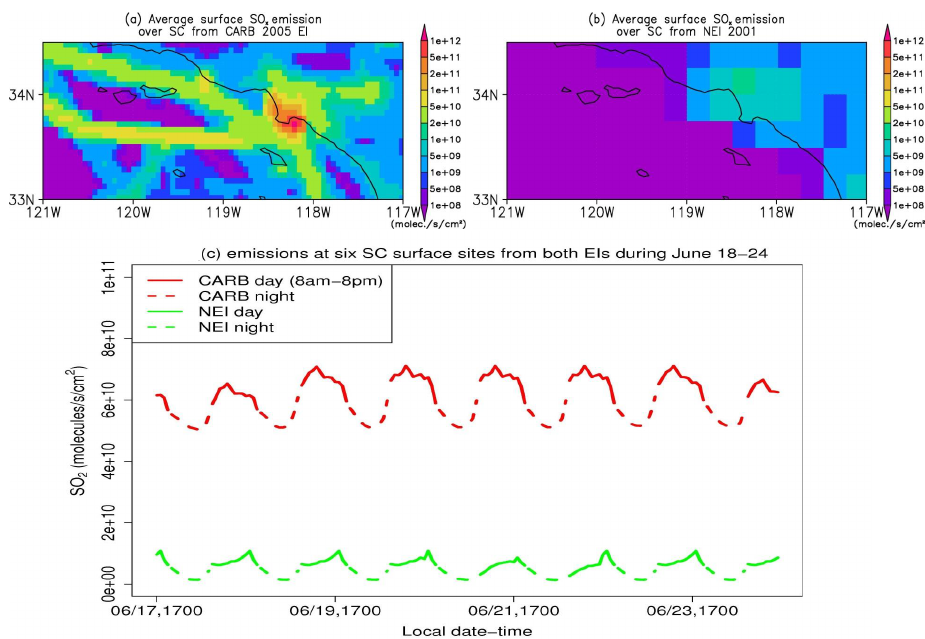
Figure 10 The average surface SO x (SO 2 +Primary SO 4 ) during June 18 -24 over SC from (a) CARB EI and (b) NEI 2001; (c) SO x surface emissions from both EIs during June 18 -24 over SC, solid and dash lines represent day Fig. 10. The average surface SO x (SO 2 +Primary SO 4 ) during 18–24 June over SC from (a) CARB EI and (b) NEI 2001; (c) SO x surface (8 am-8 pm local time) and night time, respectively. emissions from both EIs during 18–24 June over SC, solid and dash lines represent day (08:00–20:00 local time) and night time,